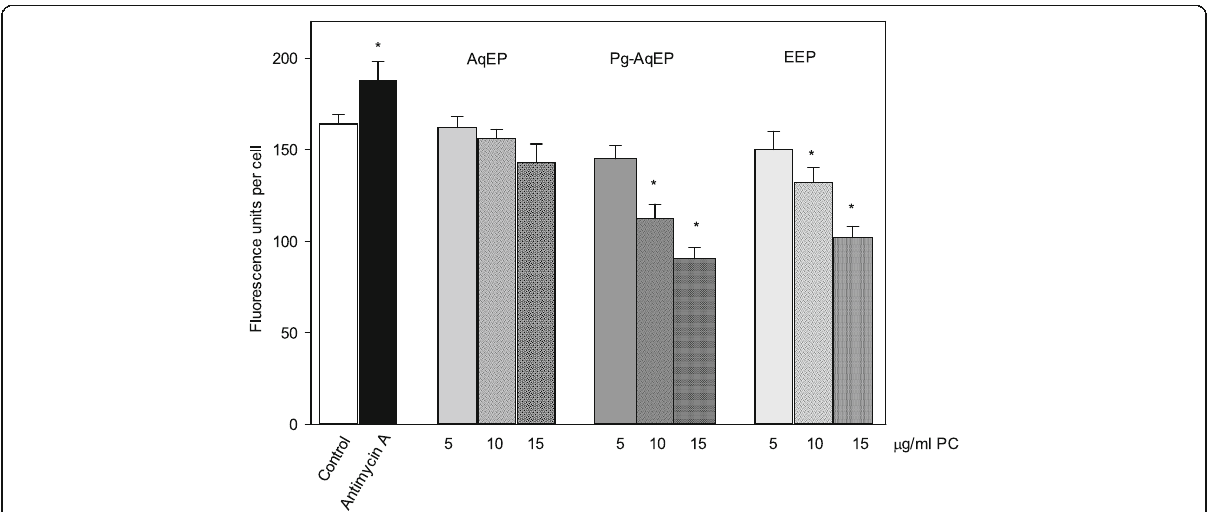
Fig. 3 Effect of propolis extracts on mitochondrial superoxide generation in C6 cells. C6 cells were pre-treated with MitoTracker Green FM (60 nM) for 45 min and with MitoSox Red (5 μ M) for 15 min. After incubation, cells were treated with different concentrations (1 – 15 μ g/ml) of AqEP, Pg-AqEP and EEP and incubated for 15 min. Solvent only-treated cells served as controls. Antimycin A (20 μ M) treated cells were used as positive control. Images were acquired under fluorescence microscope and analyzed by ImageJ freeware. Data are presented as means of percentage of control cells ± SE . * p < 0.05 versus